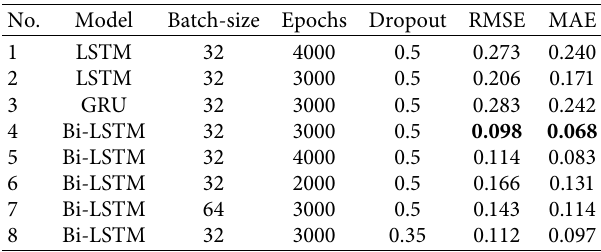
Bold shows the set of results with the best prediction effect.